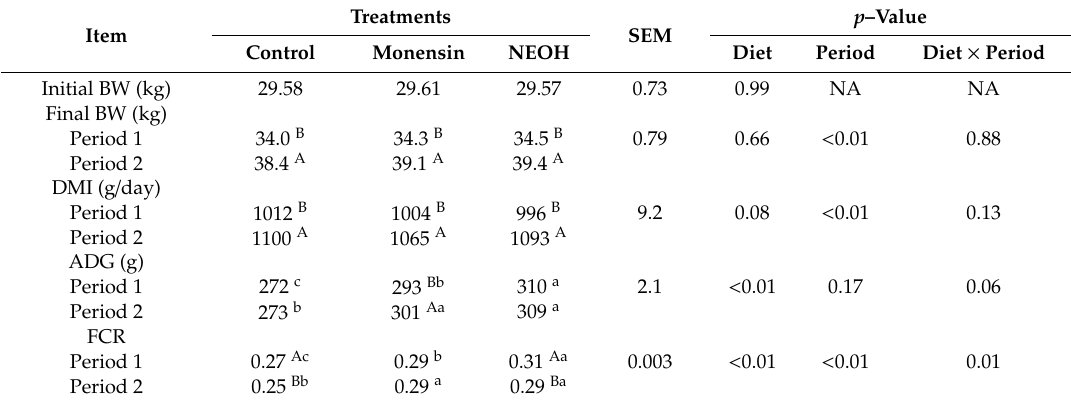
Table 3. Supplementation e ff ects of monensin and nitroethanol (NEOH) to lamb diet in feeding period